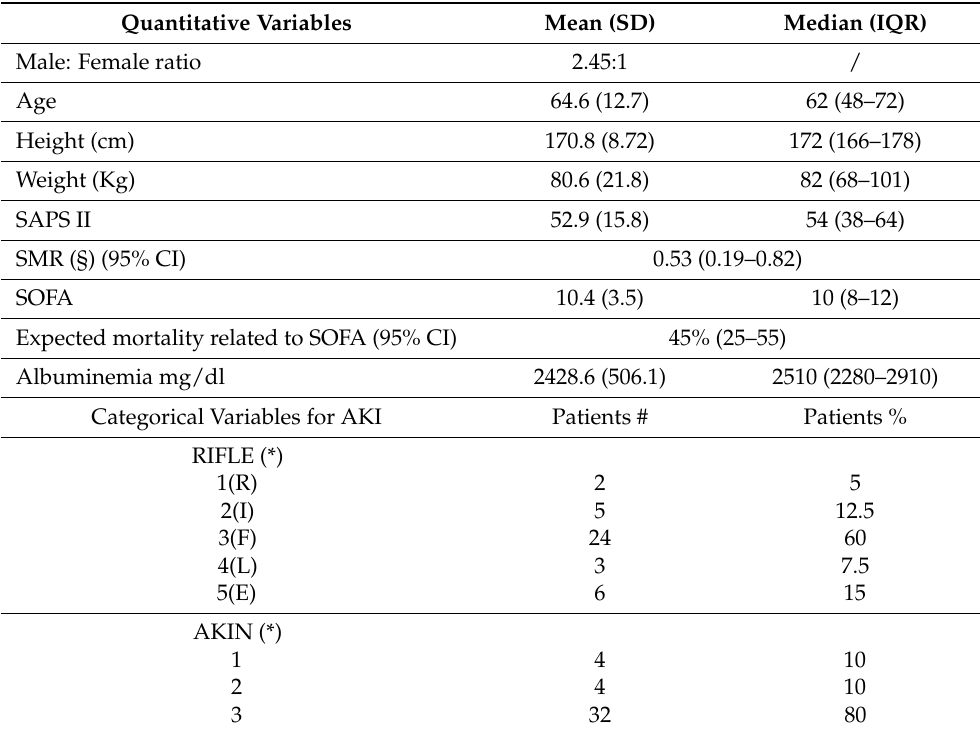
Table 1. Demographic characteristics of the studied population. Quantitative